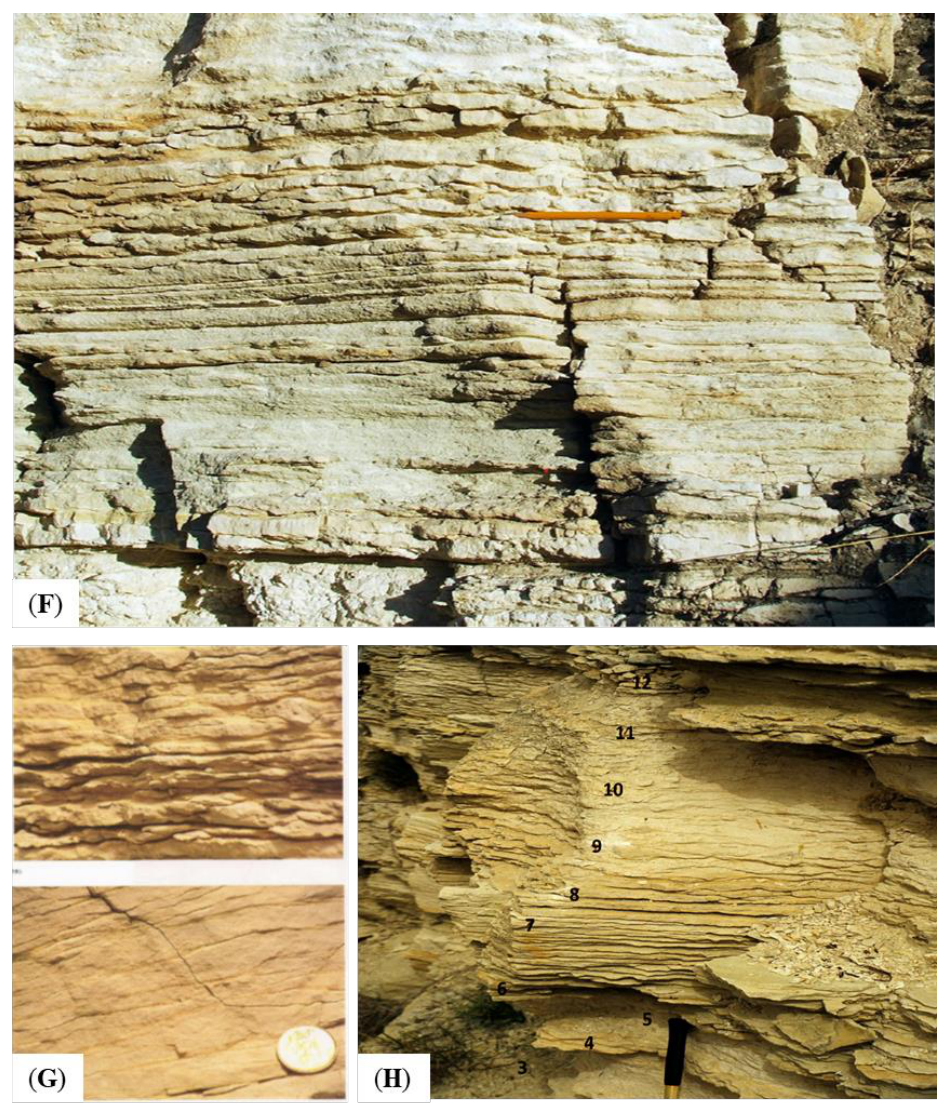
Figure 16. Contourite family: photographic examples of ancient contourites. ( A ) Miocene siliciclastic contourite succession, Rifean Gateway, Morocco. The view shows large-scale alternation of more mud-rich (grey) and more sand-rich (brown) contourites, as well as small-scale contourite cyclicity. ( B ) Detail from (a) above of sandy contourite, poorly sorted and structureless. ( C ) Detail from (a) above of muddy/silty contourite, poorly sorted and structureless. Note that surface mud wash has been partly scraped away to show a mud (grey) to silt (brown) sequence. ( D , E ) Sandy contourite succession, siliciclastic, Rifean Gateway, Morocco. The view shows large-scale cross-stratification and parallel stratification. It is interpreted as deep tidal bottom currents enhancing flow speed of thermohaline bottom currents. ( F ) Oligo-Miocene carbonate contourite succession, Petra tou Romiou, southern Cyprus. A pencil lying along typical lenticular calcarenite contourite facies is shown. ( G ) Oligo-Miocene carbonate contourite succession, Petra tou Romiou, southern Cyprus. Bi-gradational sequence from calcilutite/calcisiltite near base (hammer handle, sampling numbers 3–4) to lenticular calcarenite (numbers 6–9) to calcilutite/calcisiltite (sampling number 10). ( H ) Detail of lenticular calcarenite contourites.